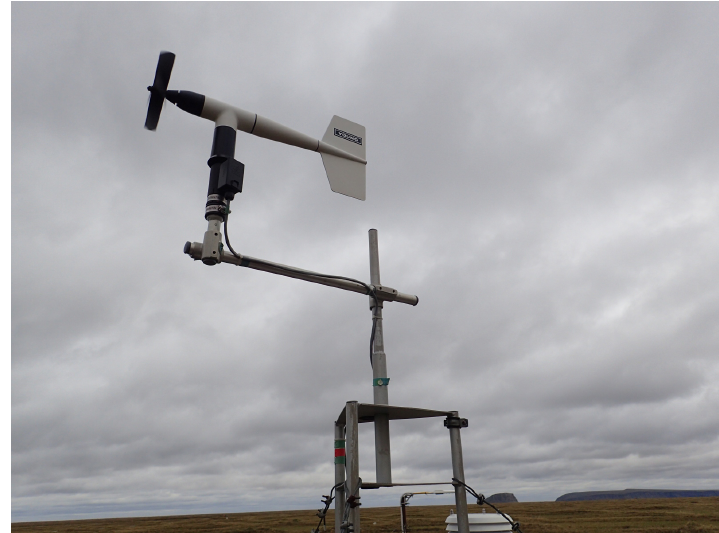
Figure B2. Young 05103 wind monitor for measuring wind direction and speed, installed on 31 August 2002.